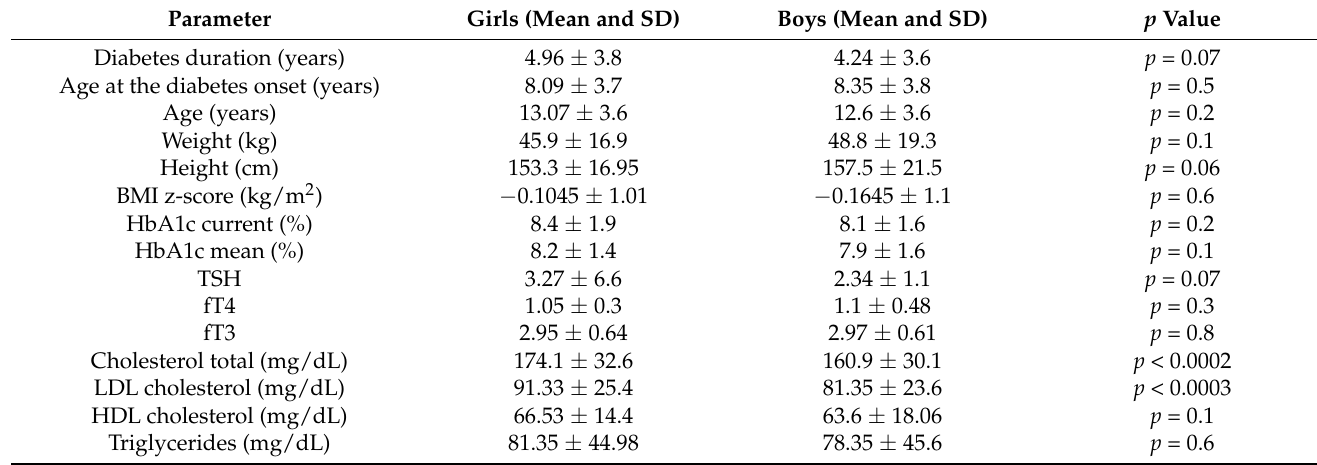
Table 1. Characteristic of studied population divided into